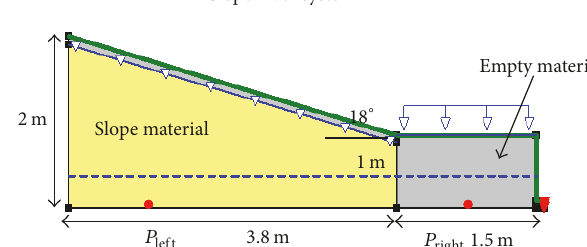
Figure 9: Geometry of numerical model.